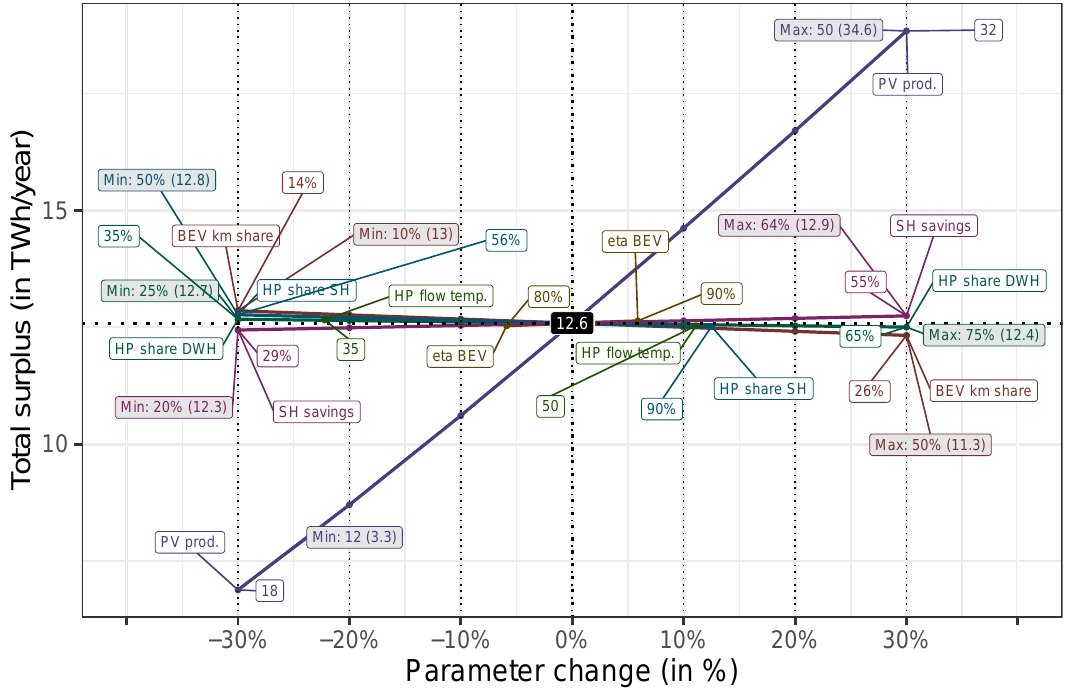
Figure 21. Sensitivity plot of the total annual electricity surplus with respect to plausible percentage changes of the key parameters in Table